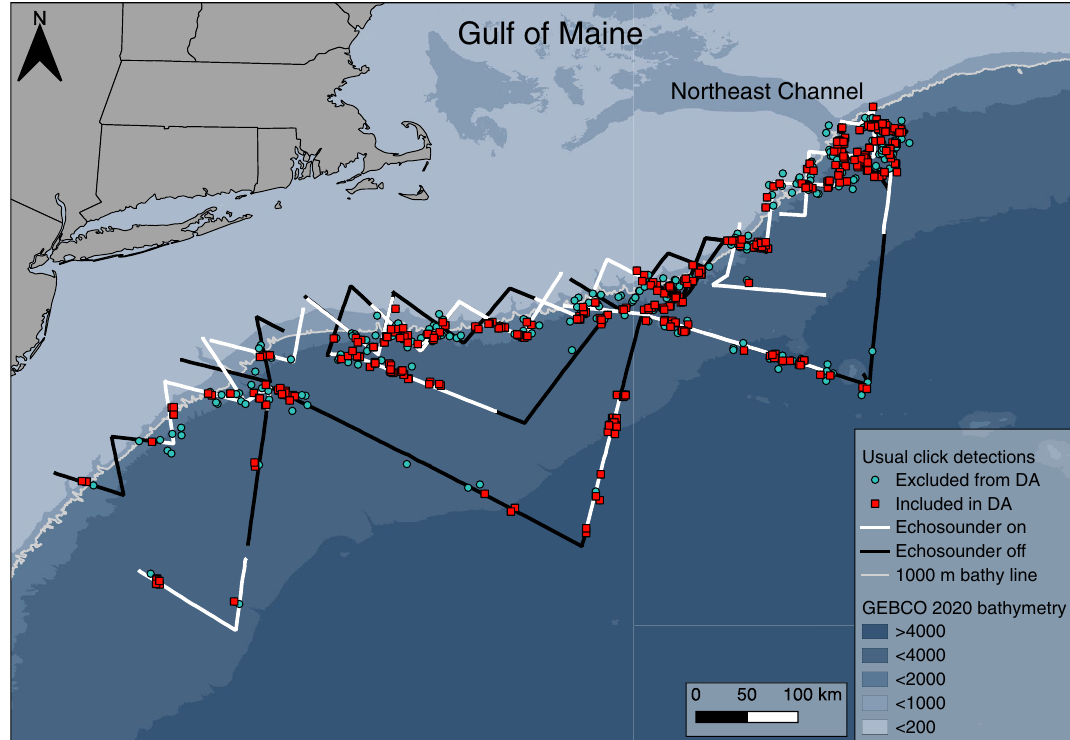
Figure 4. Map of the survey conducted between June 27 and August 25, 2016, in the western North Atlantic and covering 5661 km. Marked events are of sperm whale usual click trains (n = 712) coloured based on whether it was included (n = 431) or excluded (n = 281) from the distance analysis (DA) if 2D localization was not possible or after truncating at a slant range of 6500 m.